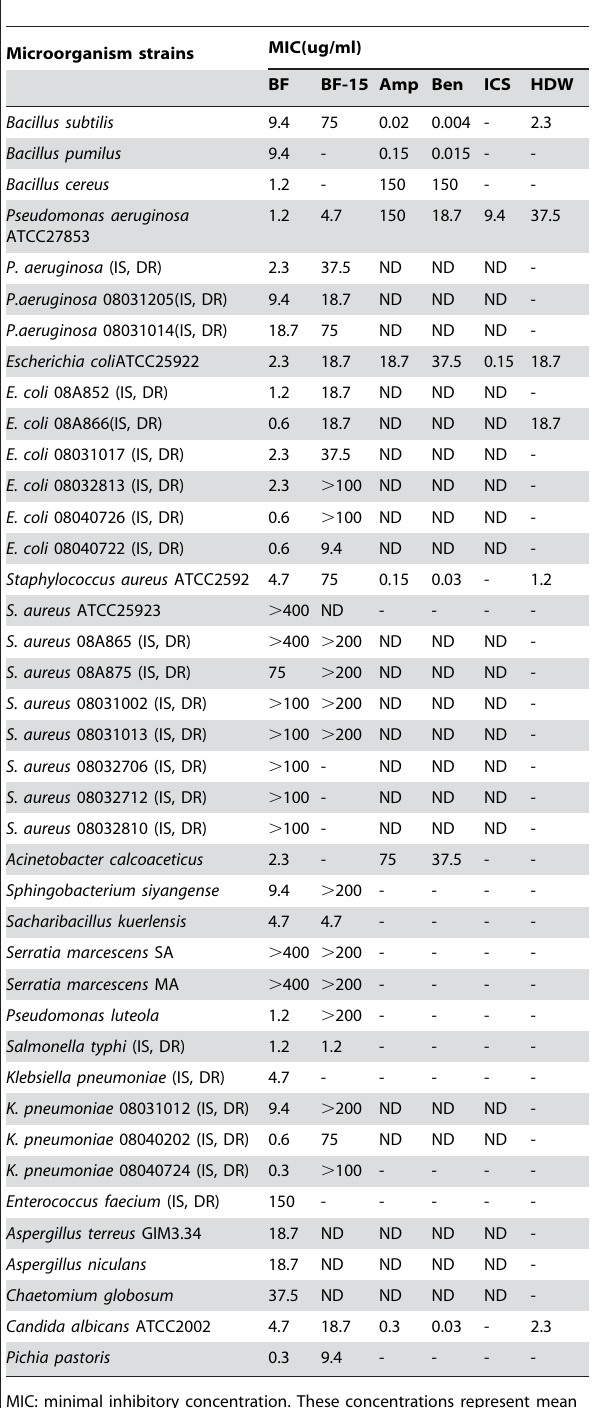
Table 1. antimicrobial activity comparison of cathelicidin-BF with antibiotics.